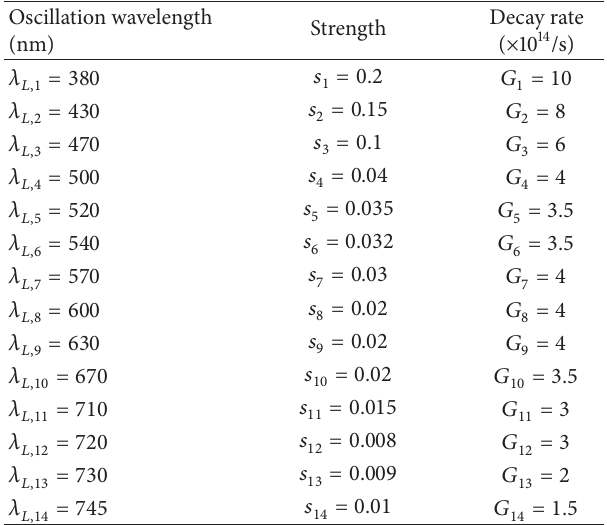
Table 1: Fitted parameters of the Lorentz model for TPA